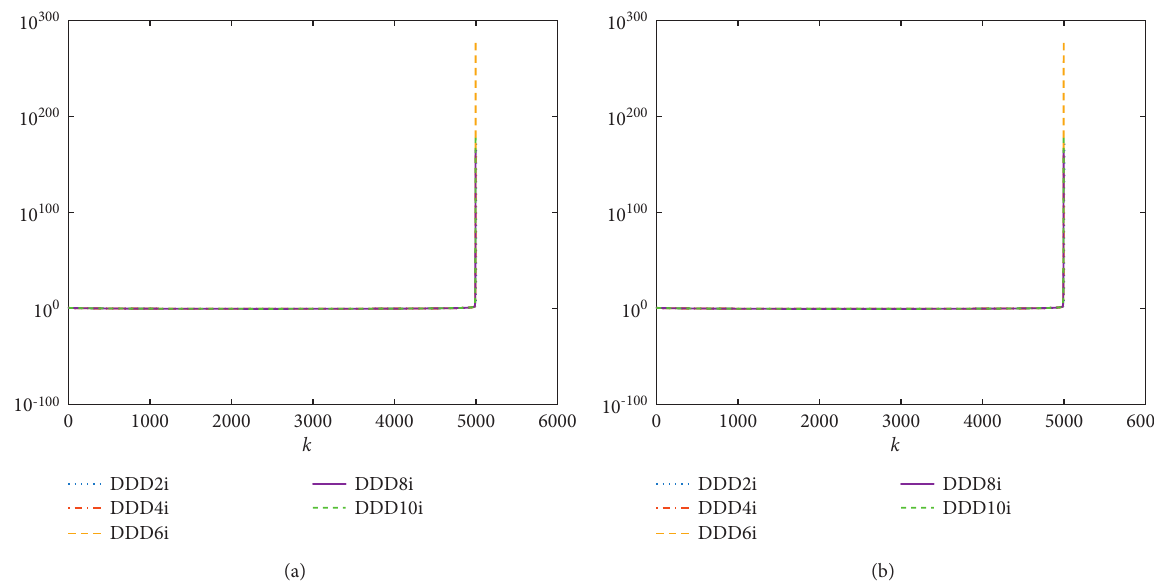
Figure 5: Residual error trajectories synthesized by five DDD algorithms for example 1 (with ϵ � 0 . 001 s and c � 5 . 0). (a) Trajectories of ‖